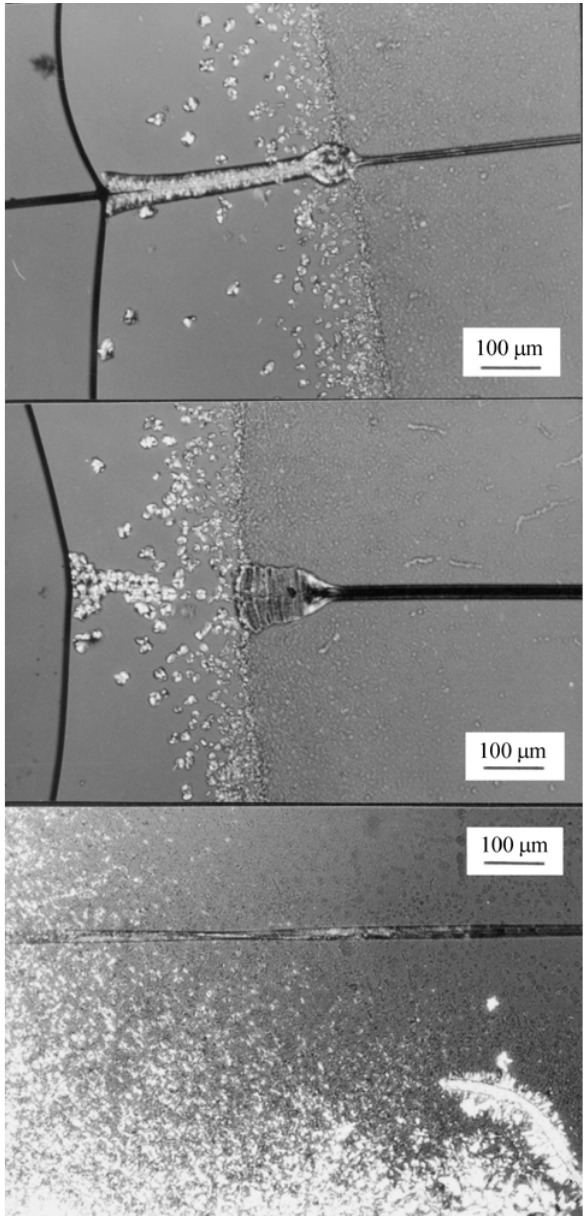
Figure 4. Effect of matrix flow during sample preparation on subsequent crystallization along temperature gradient. Well developed transcrys- talline layer in (a), melting of UHMWPE fiber in (b), transcrystallization along molten fiber remnant in (c). Original magnification 100X.